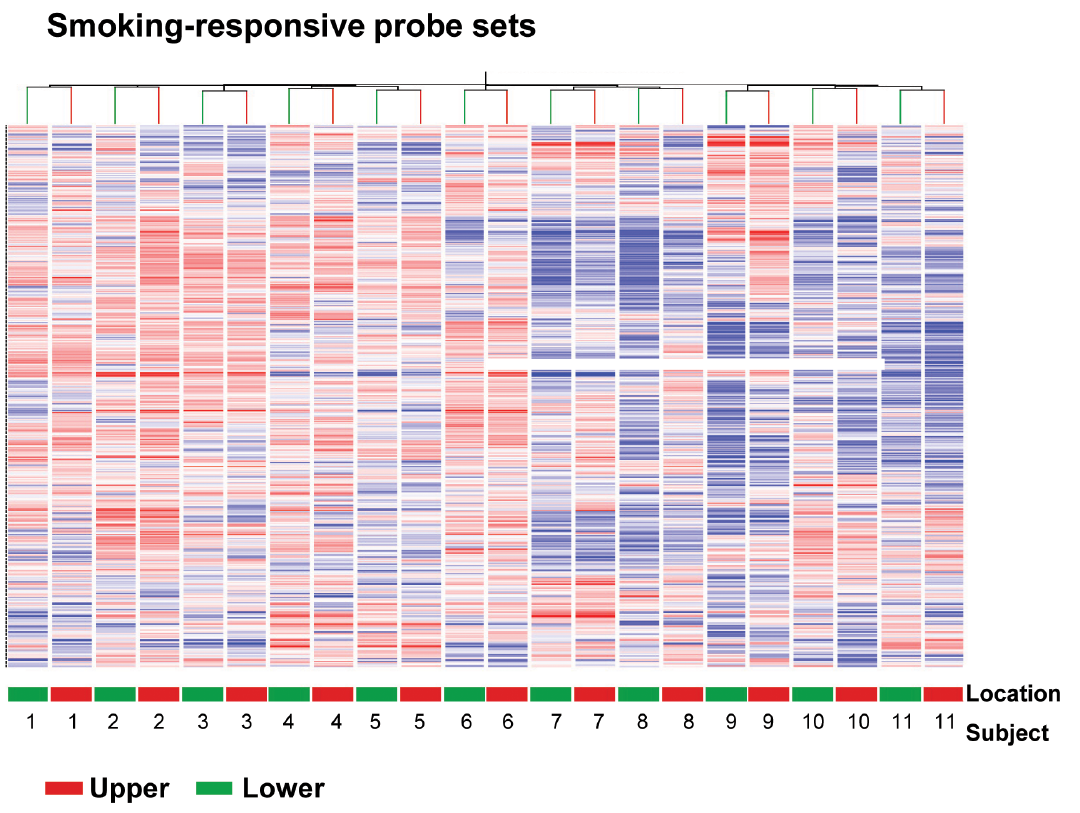
Figure 3. Cluster analysis of upper vs lower lobe gene expression to assess if, for each individual, the expression of known smoking-responsive genes is highly correlated in the upper vs lower lobes. Shown is a cluster analysis of small airway epithelium 529 known smoking-responsive probe sets corresponding to 372 genes [25]. Note that the smoking-responsive gene expression of the upper vs lower lobes for each of the 11 subjects clusters together.